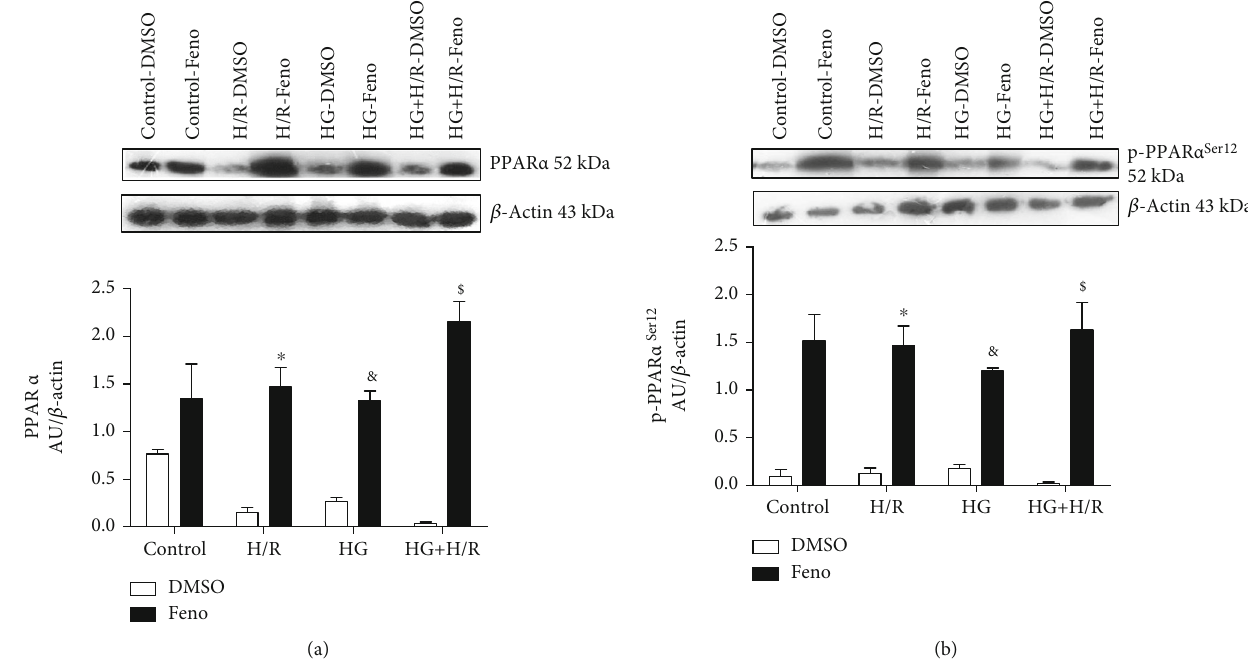
Figure 9: Feno fi brate (10 μ M) increases peroxisome proliferator-activated receptor alpha (PPAR α ) and phospho-PPAR α Ser12 expression in primary cultures of cardiomyocytes undergoing hypoxia/reperfusion (H/R), high glucose (HG), and HG+H/R. Protein expression and densitometric analyses of (a) PPAR α and (b) phospho-PPAR α Ser12 were performed. DMSO = dimethylsulfoxide (0.1%); Feno = feno fi brate (10 μ M). # p < 0 : 05 vs. control-DMSO; ∗ p < 0 : 05 vs. H/R-DMSO; & p < 0 : 05 vs. HG-DMSO; $ p < 0 : 05 vs. HG+H/R-DMSO. Values represent the mean ± SEM of 6 di ff erent experiments. Two-way analysis of variance (ANOVA) followed by Tukey ’ s post hoc